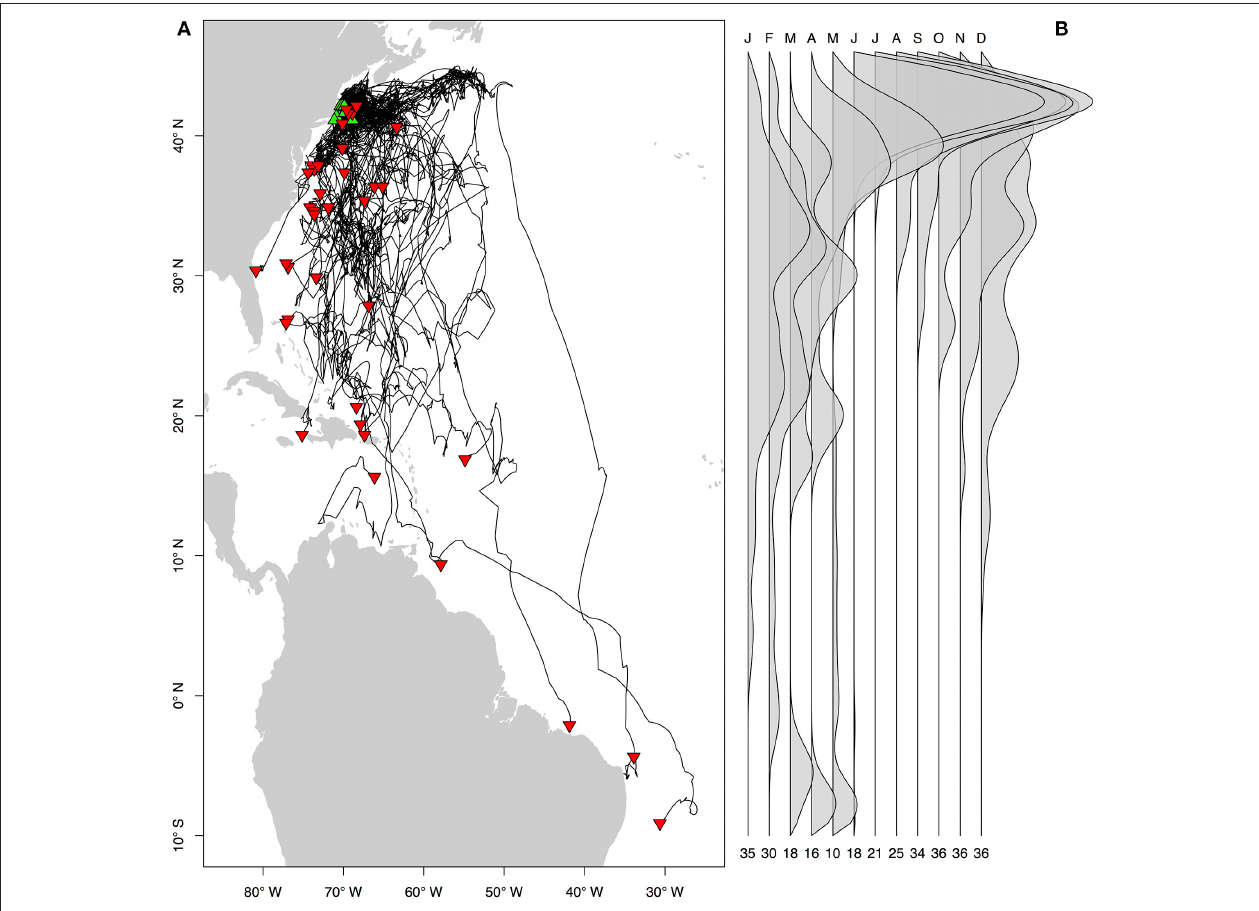
FIGURE 2 | Most probable tracks (A) and latitude density by month (B) for 37 basking sharks satellite-tagged off New England during June through October of 2004–2011. Tracks are plotted as black lines, and green and red triangles represent tag and pop-up locations, respectively. Letters above the density plot indicate month (e.g., F = February), and numbers below indicate the number of individuals with tag data during that